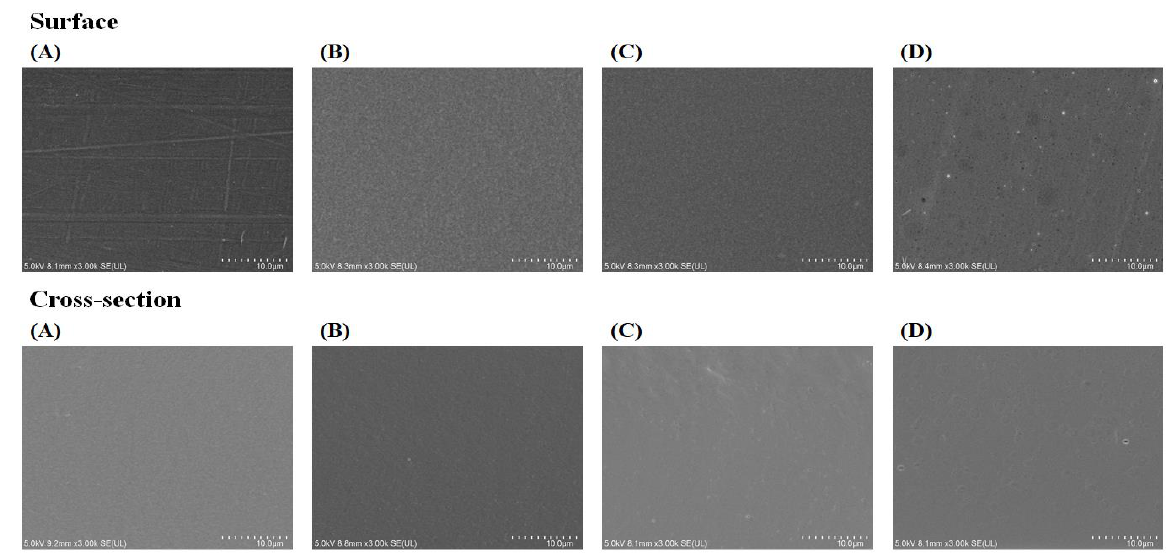
Figure 1. SEM images of GBS films containing CZEO. ( A ) GBS-C; ( B ) GBS-0.1; ( C ) GBS-0.3; ( D ) GBS-0.5.